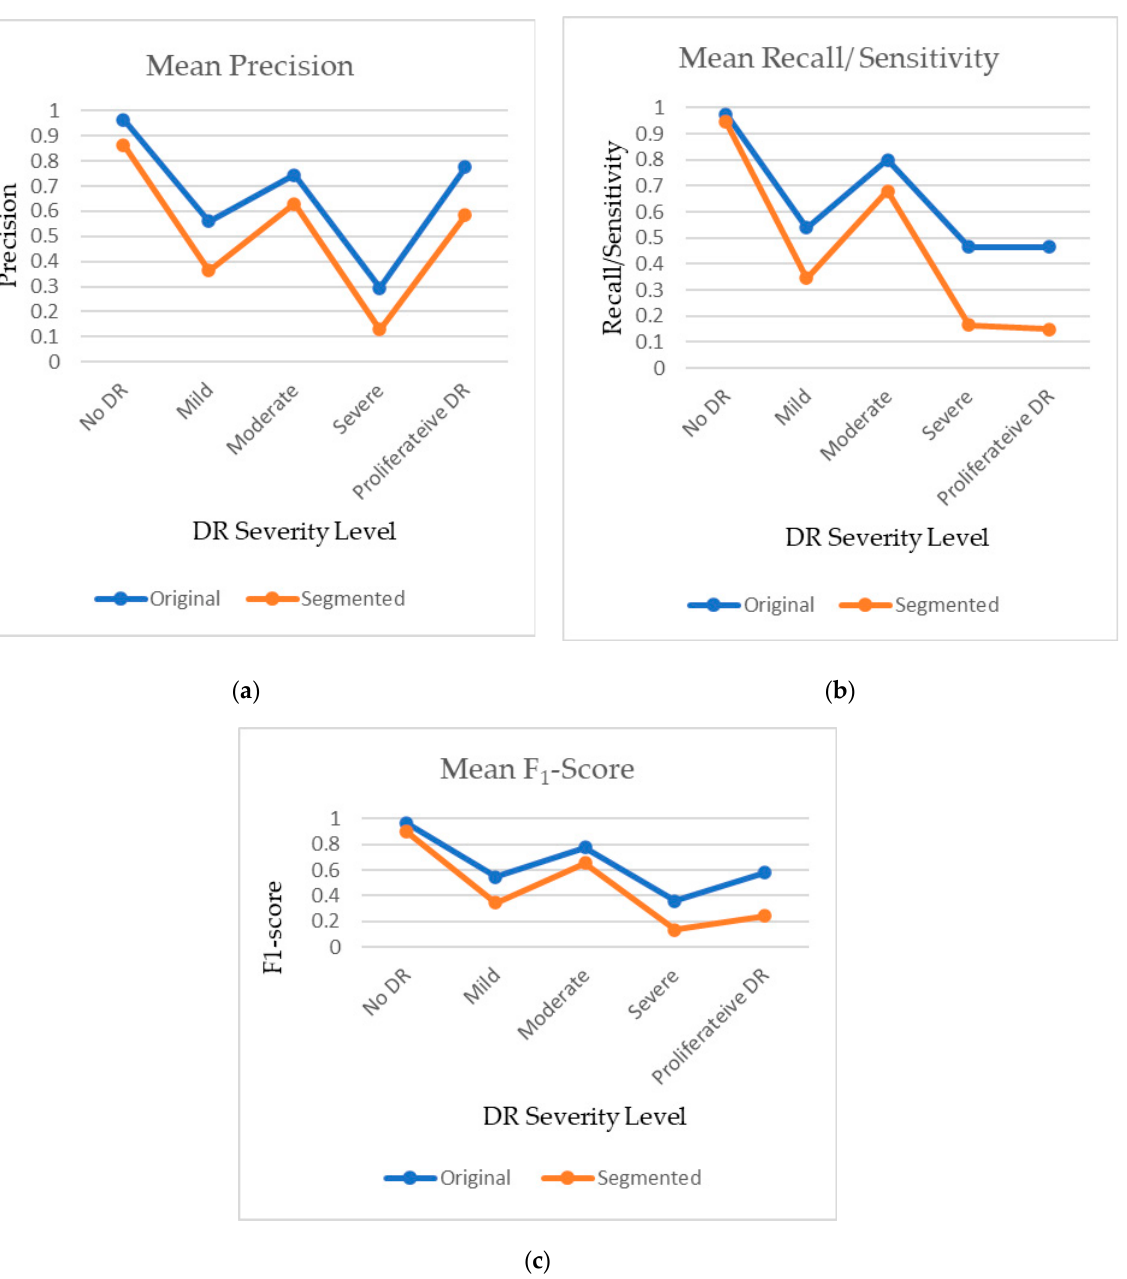
Figure 6. Plot of mean ( a ) precision, ( b ) recall, and ( c ) F 1 -Score for original and segmented